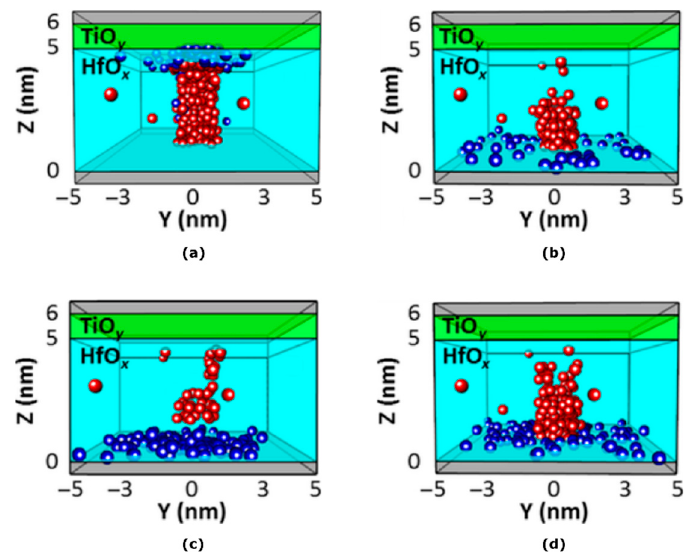
Figure 10. Simulated distributions of oxygen ions (blue) and vacancies (red) in TiN/5 nm HfO x /TiO y /TiN RRAM stacks: ( a ) after forming; ( b ) after the reset operation with slow and anisotropic oxygen diffusion, showing an efficient reset process; ( c ) after the reset operation with excessively fast and anisotropic oxygen diffusion, showing an inefficient reset process with the formation of a dielectric barrier near the bottom electrode; ( d ) after the reset operation with slow and isotropic oxygen diffusion (with significant motion in the radial direction), showing an inefficient reset process due to the excessive motion of the oxygen ions away from the CF.